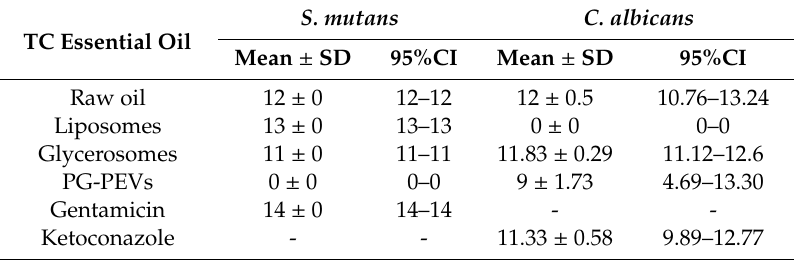
Table 4. Descriptive statistics for the antimicrobial activity of TC essential oil against the microorganisms using the disc di ff usion assay.